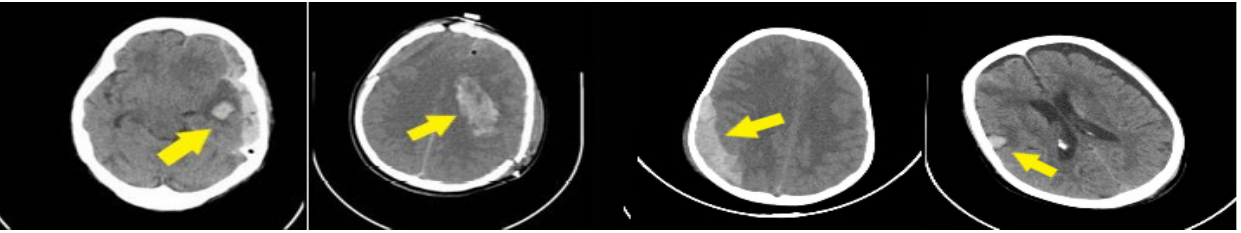
Figure 1. Stroke instances from the dataset.